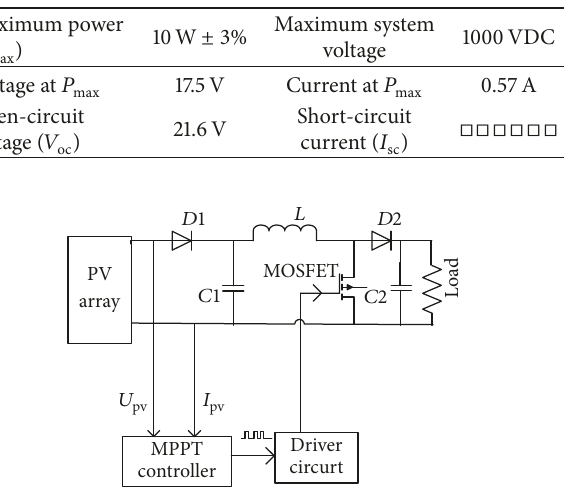
Figure 10: Real-time measurement data.